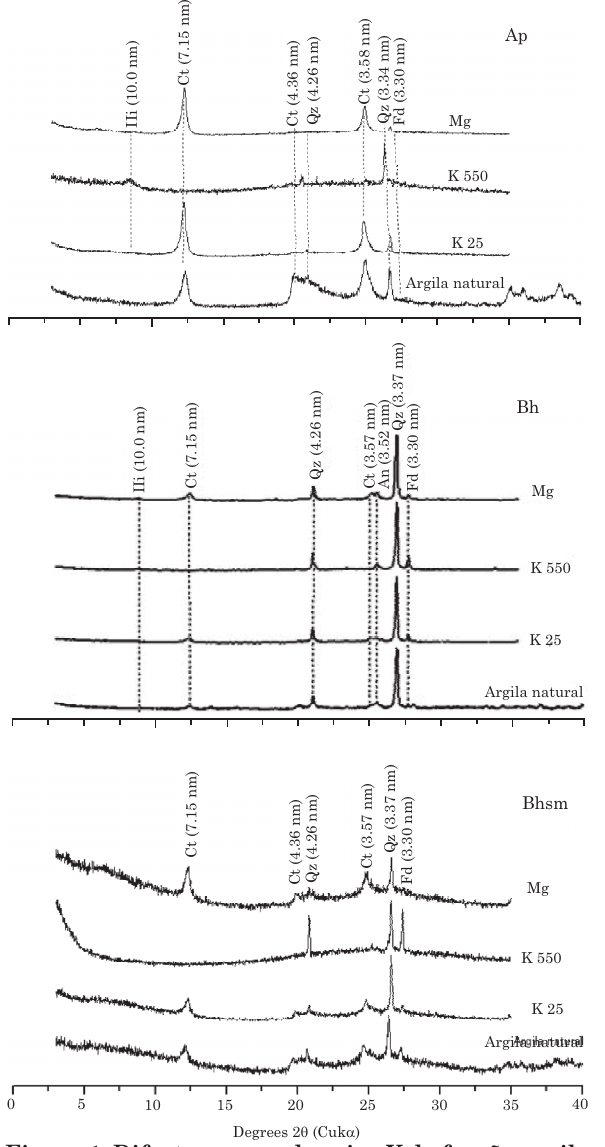
Figura 1. Difratogramas de raios-X da fração argila dos horizontes Ap, Bh e Bhsm, do perfil 1. An: anatásio; Ct: caulinita; Fd: feldspato; Gb:gibbsita; Gh: goethita; e Qz: quartzo.